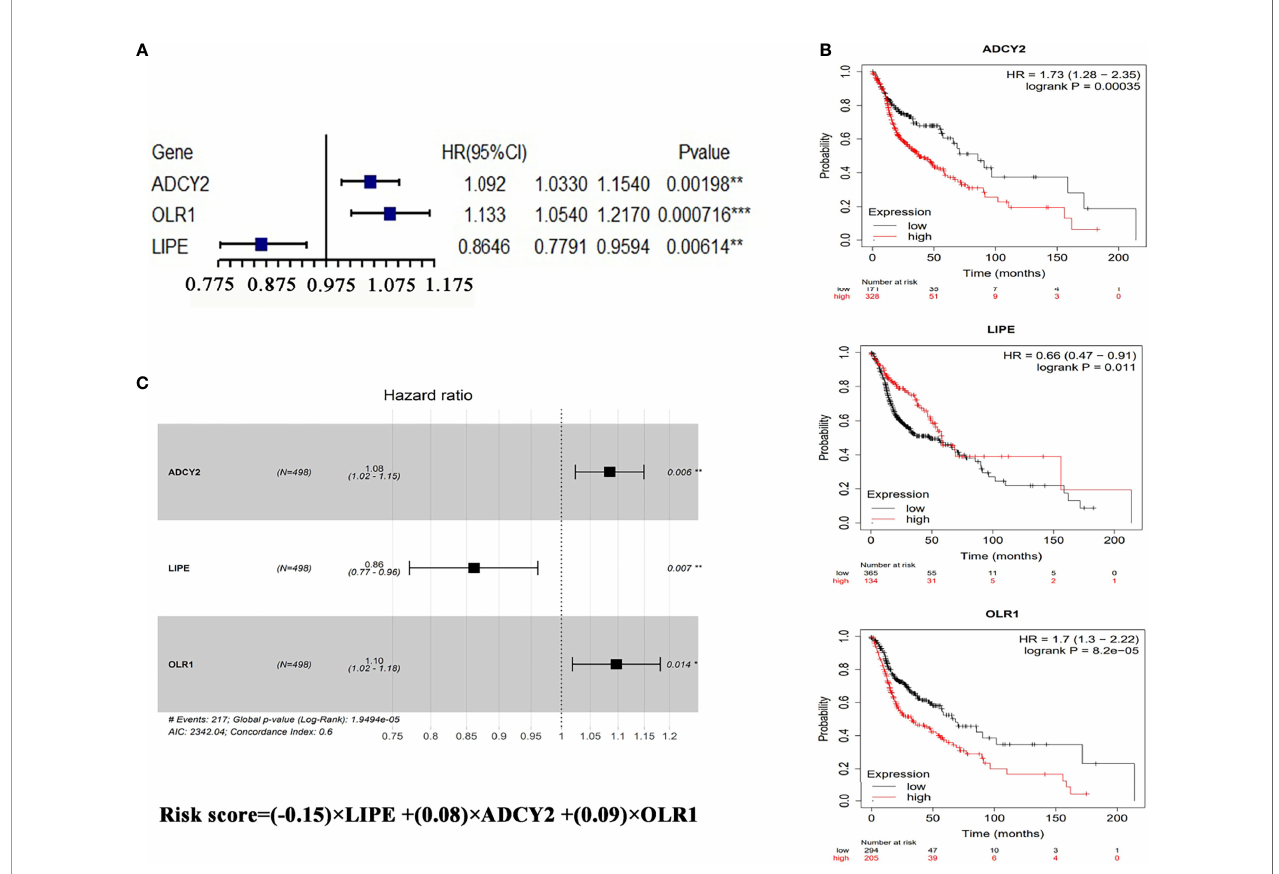
FIGURE 3 | Prognostic analysis of LRPS genes. (A) Univariate Cox analysis of OLR1, ADCY2, and LIPE. (B) Survival analysis of the three genes in HNSCC according to the Kaplan – Meier Plotter online database (http://kmplot.com/analysis/index.php?p=background). (C) The risk score performed using multivariate Cox analysis of the three genes. *p < 0.05, **p < 0.01, ***p <